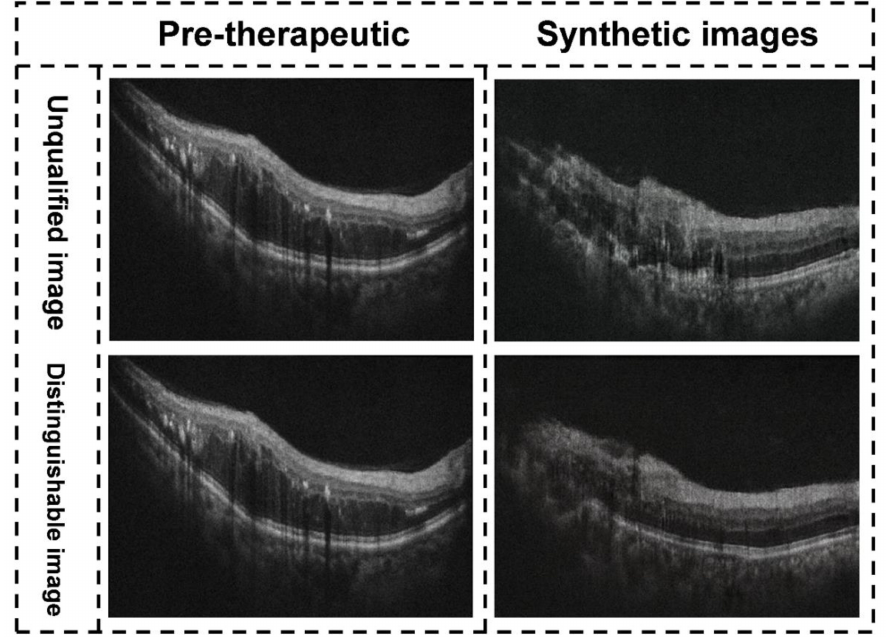
Figure 4. Examples of unqualified and distinguishable synthetic images. Illustration of the synthetic OCT images with different quality types. The images in the left column are pre-therapeutic images, and the images in the right column are synthetic post-therapeutic images by the pix2pixHD. The image on the upper right was considered inadequate by two retinal specialists during the evaluation process because it did not reflect the actual retinal structures; the image on the lower right was considered distinguishable by two retinal specialists during the evaluation